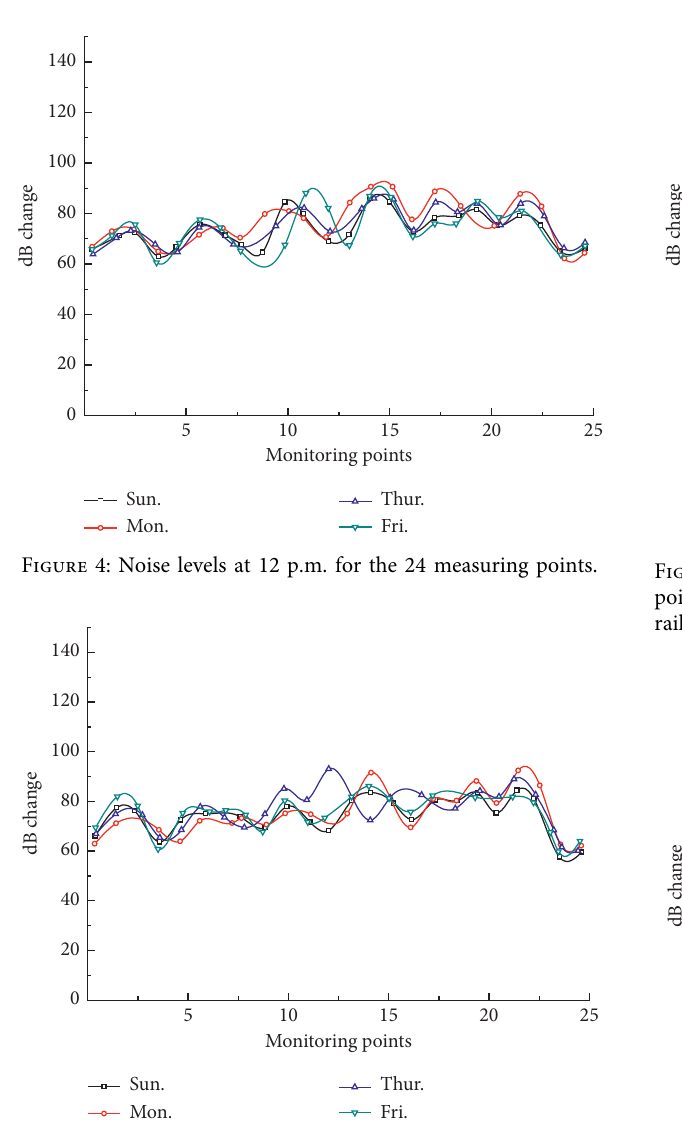
Figure 5: Noise levels at 6 p.m. for the 24 monitoring points.